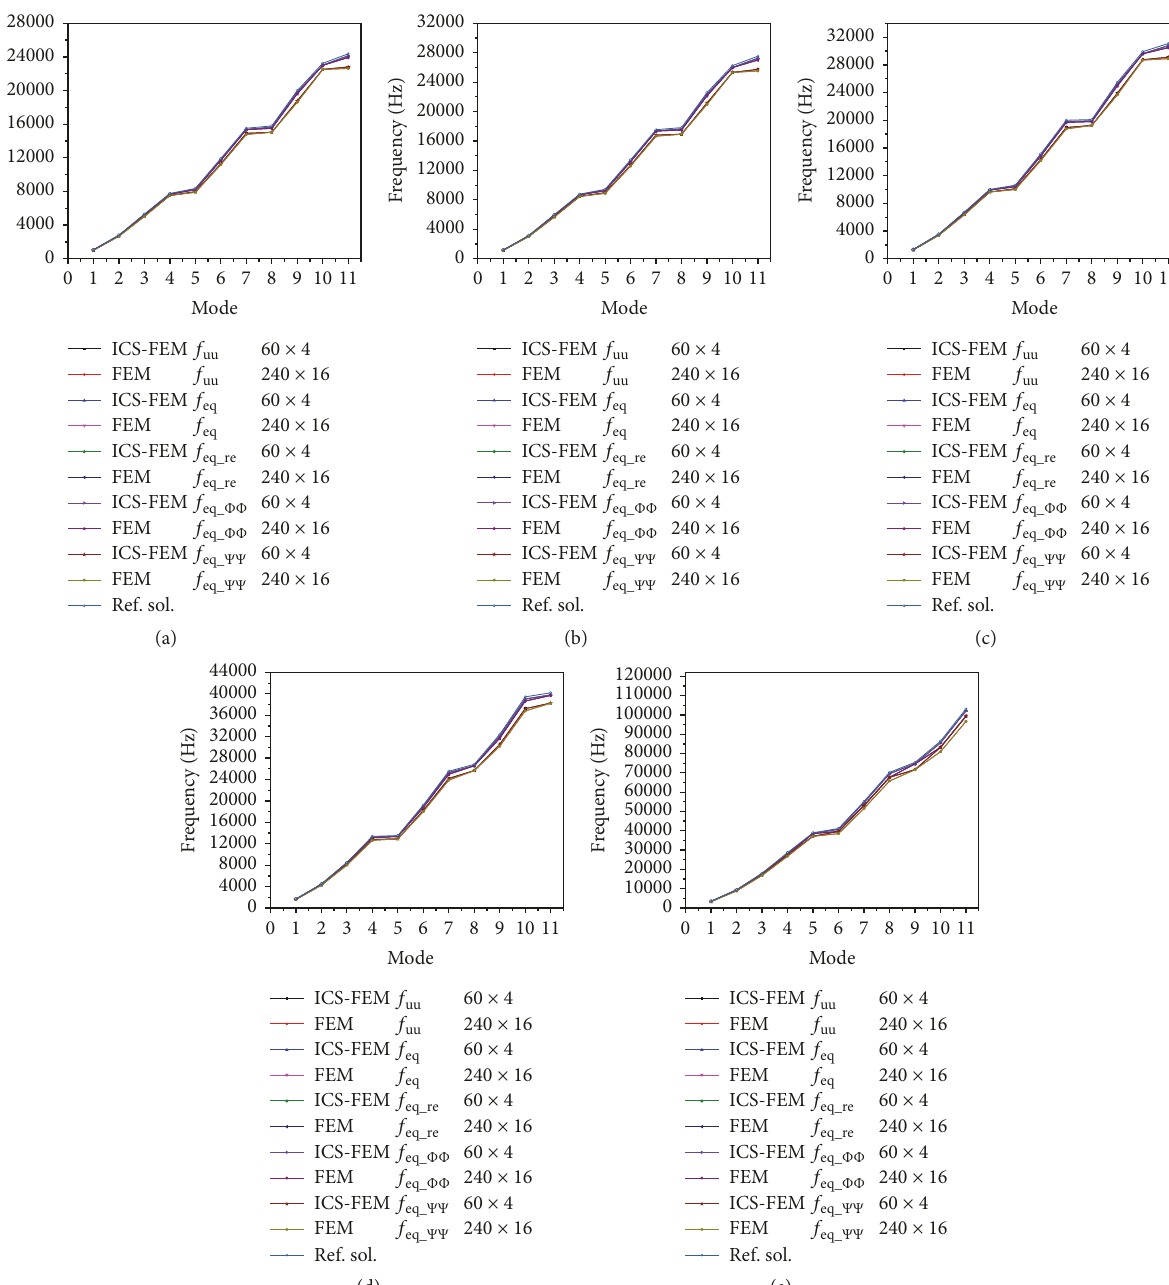
Figure 14: Structural frequencies 𝑓 for BaTiO 3 FGMEE energy harvester with exponential factor 𝜂 = (a) 0, (b) 0.5, (c) 1.0, (d) 2.0, and (e) 5.0.